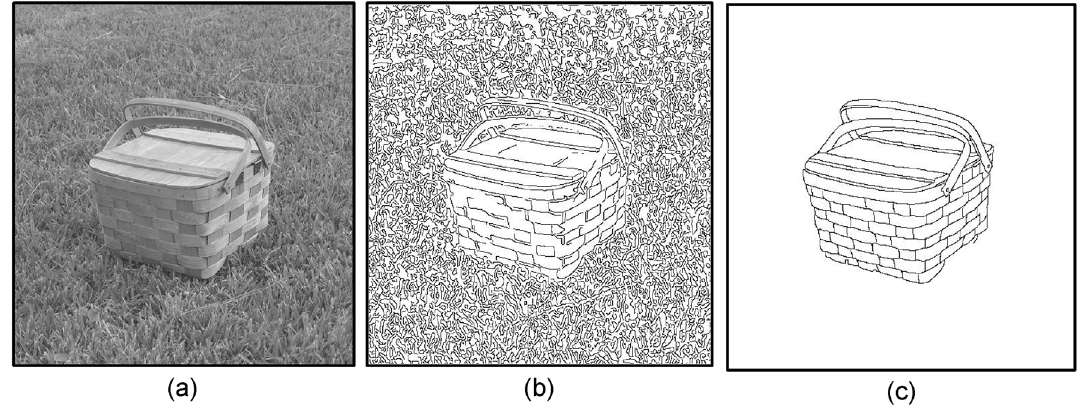
Figure 1. ( a ) A basket and grasses in the background. ( b ) Result of Canny detection 4 , H t = 0.2 , L t = H t × 0.4 . ( c ) Contours perceived by the human visual